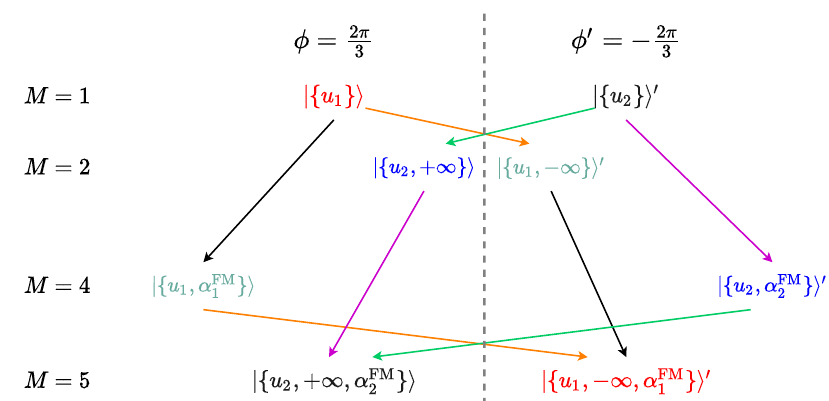
}〉 and |{ u }〉 (cid:48) 1 2 π and φ (cid:48) = − φ . Like in Fig. 6 3